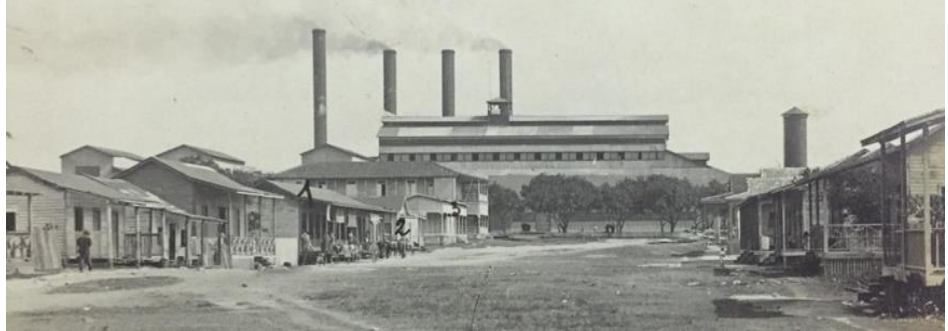
Figure 1. Cuban American Sugar Company, Chaparra Mill. 9